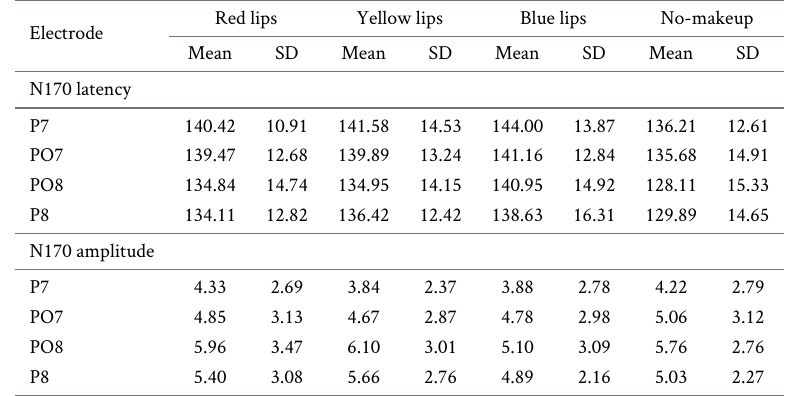
Table 3. Mean N170 latency (ms) and amplitude ( µ V) for all conditions at four-electrode sites.